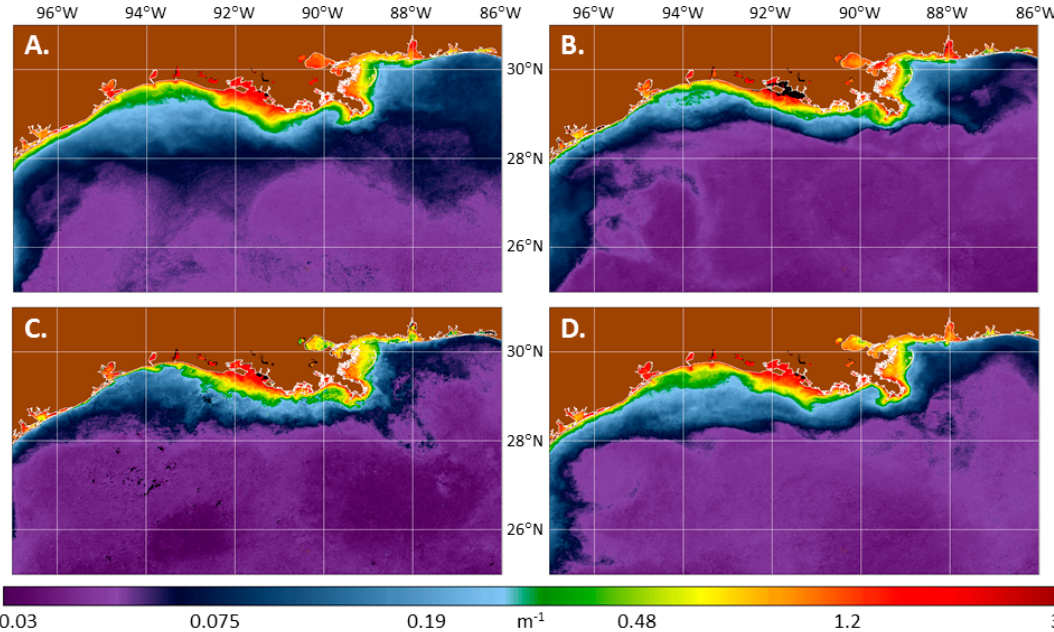
Figure 3. Moderate Resolution Imaging Spectroradiometer (MODIS) Kd (488), 2006. ( A ) January; ( B ) April; ( C ) July; ( D ) October. Color scale units are m − 1 .